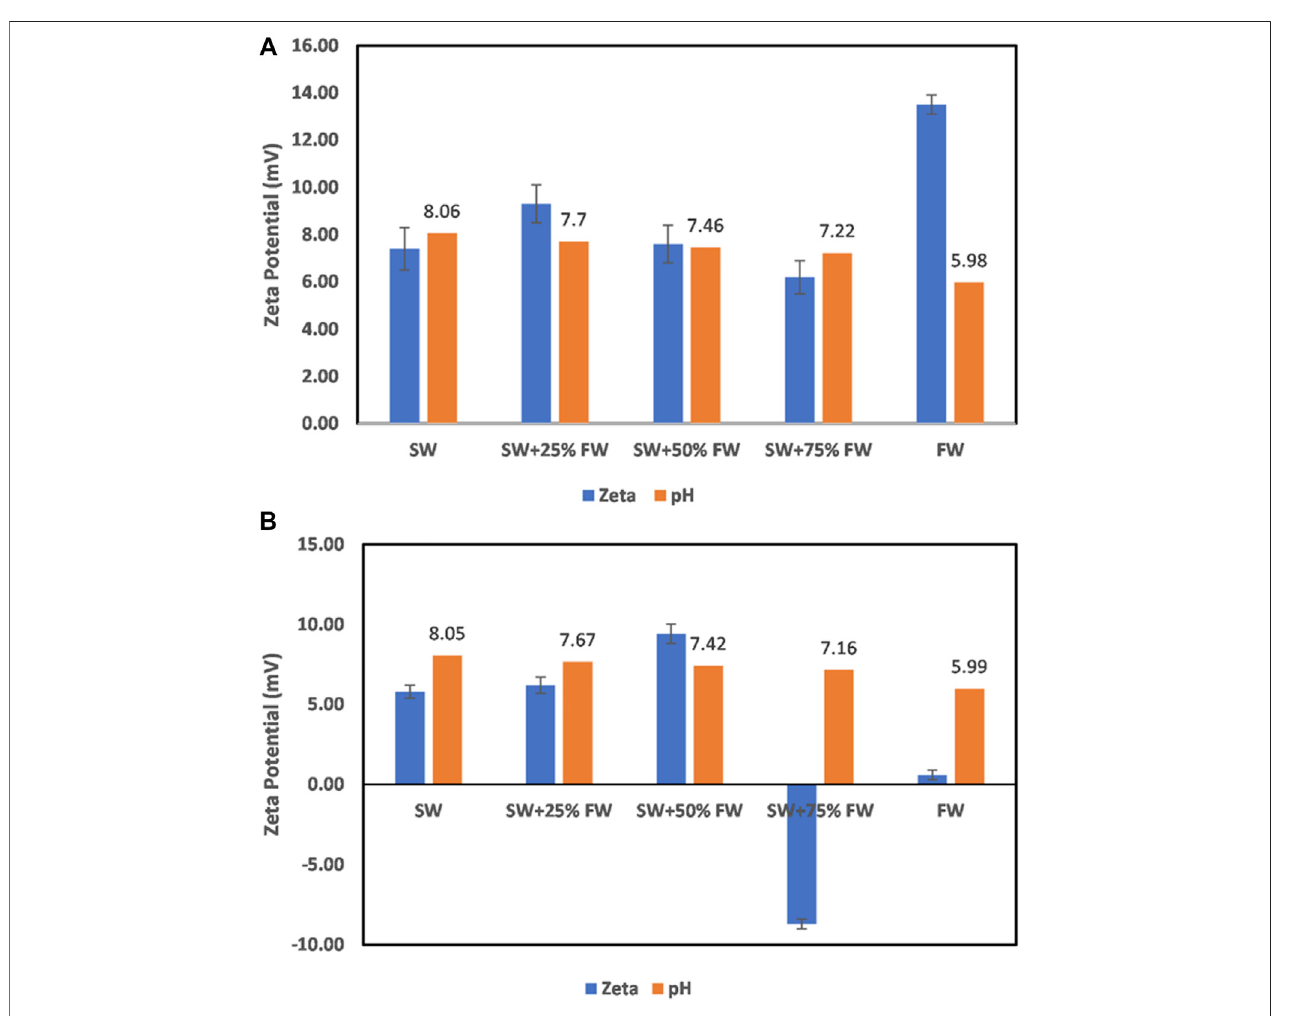
FIGURE 11 | Salinity gradient effect. (A) Barite and (B) dolomite.